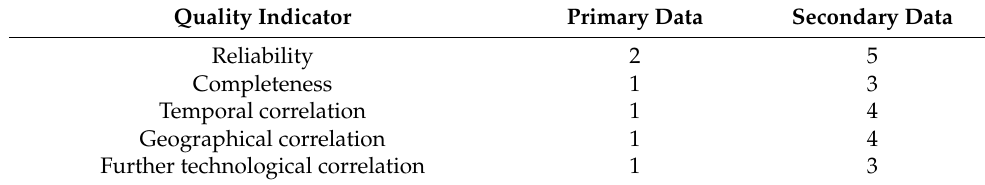
Table 3. Data quality analysis. Quality